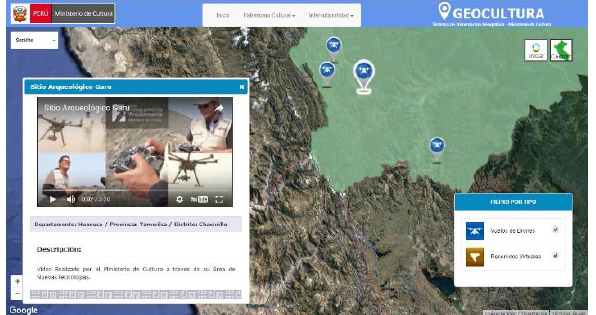
Figure 4. Expressions of the Intangible Cultural Heritage of Peru. © Qhapaq Ñan Sede Nacional. Image: Screen capture, 2017. Ministerio de Cultura, Gobierno de Perú.